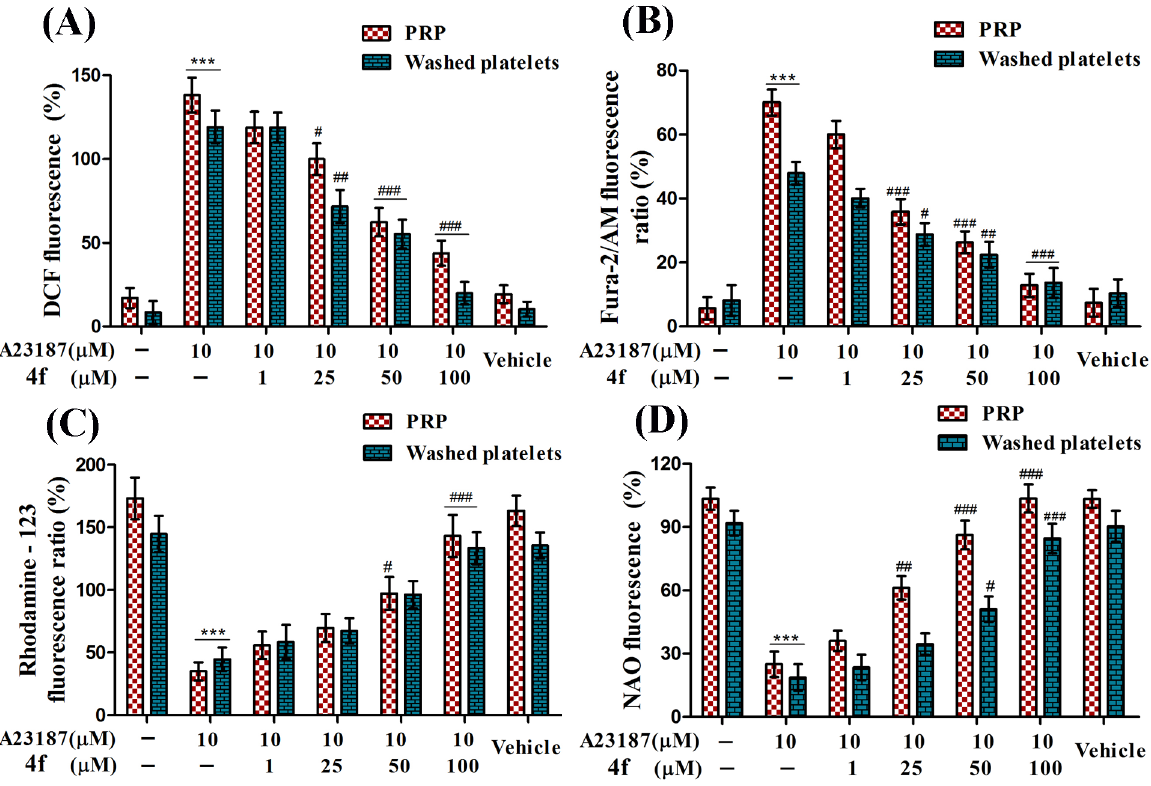
Figure 3. Effect of compound 4f on A23187 induced (A) Endogenous generation of ROS (B) Intracellular calcium levels (C) Mitochondrial membrane depolarization and (D) Peroxidation of cardiolipin in PRP and washed platelets. Values are presented as mean 6 SEM (n=5), expressed as percentage increase in DCF fluorescence (for ROS), percentage increase in Fura-2/AM fluorescence (intracellular calcium), Rhodamine 123 fluorescence ( DY m ) and NAO fluorescence (cardiolipin), relative to control. *** p , 0.001; significant compared to control. # p , 0.05, ## p , 0.01, ### p , 0.001; significant compared to A23187.